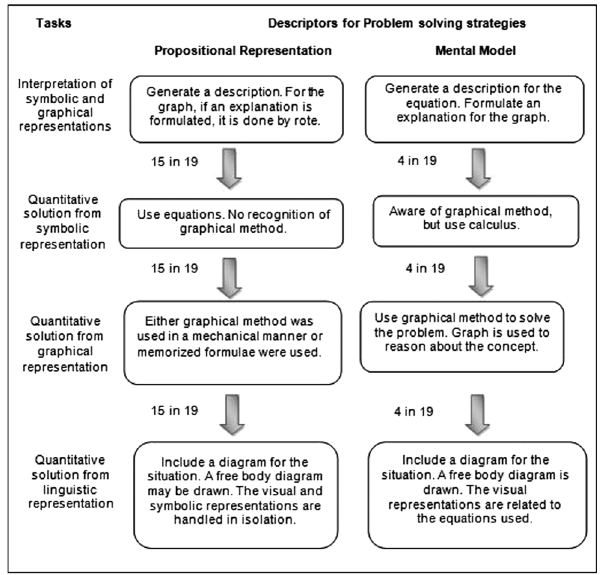
FIG. 13. Descriptors which define students within the profile for the category of propositional representation and mental model in work.